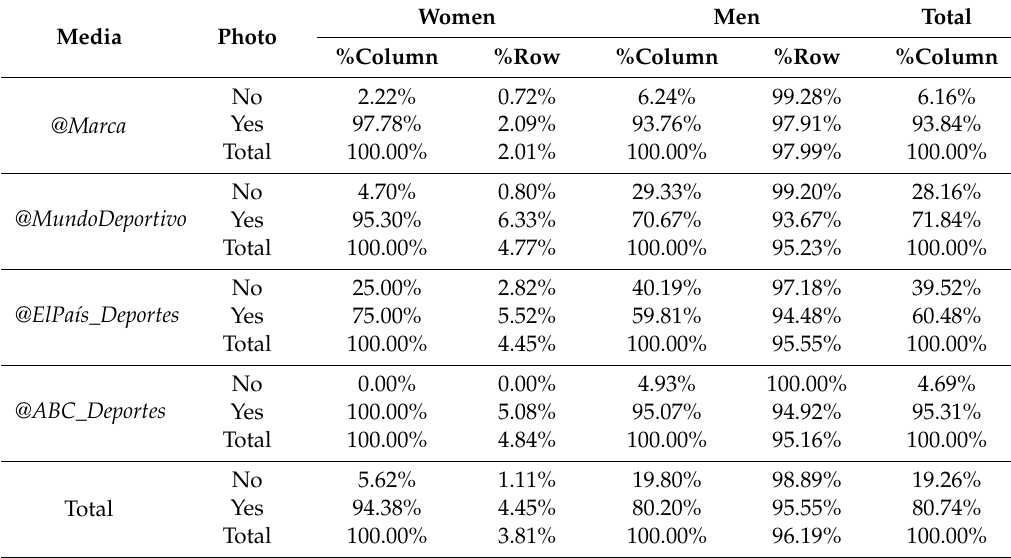
Table 4. Sample distribution of gender according to the communication media and accompanying photo in tweets (n =